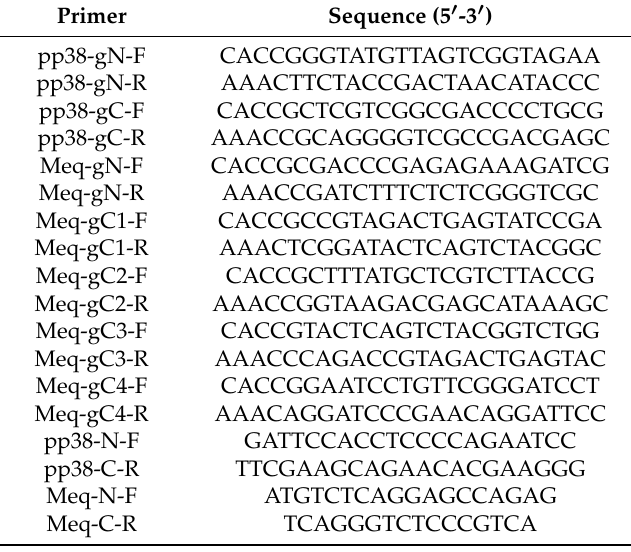
Table 1. List of primer sequences for gRNA cloning and identification of